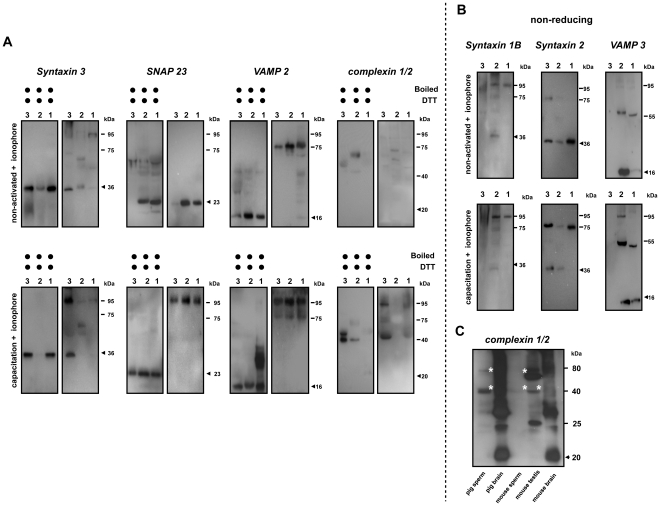
Bicarbonate and Ca2+ ionophore incubation results in MVs that contain high amounts of SNARE protein complexes.(A) When MVs were formed in the presence of bicarbonate and Ca2+ ionophore, a considerable amount of SNARE protein complex was present at 95 kDa (lower panels). A minimal amount of 95 kDa SNARE complexes was observed in MVs from the non-activated sperm when AE was induced by Ca2+ ionophore in the absence of bicarbonate (upper panels), although a 75 kDa VAMP 2 was found under this bicarbonate depleted condition. Besides the three interacting SNARE proteins found in the MVs, we also identified the capacitation-dependent participation of soluble complexin with the SNARE containing complex. (B) This shows the absence of previously reported SNARE proteins (to some extent syntaxin 1B is present in a 95 kDa complex but syntaxin 2 and VAMP 3 are not participating) in the non-activated MVs indicating that pre-docking and fusion of the acrosome with the PM requires different sets of SNARE proteins. (C) Identification of sperm and testis specific forms of complexin. To demonstrate that the unexpected 40 kDa complexin was not an artifact, whole sperm lysates and a mouse testis tissue homogenate were used. For the comparisons between different tissues, both pig and mouse brain homogenate were included. Despite the presence of multiple complexin positive bands, we found in both mouse and pig brain, a huge amount of complexin monomer was present. In contrast to the specific detection of 40 and 79 kDa complexin (marked with asterisks) in the sperm and testis, no 40 kDa complexin can be detected in the brain tissue of both species suggesting this unexpected 40 kDa complexin is a sperm-specific form rather than the artifact. A total of 35 µg crude protein was loaded to each lane of these Western blots from: 1: whole sperm cell lysate; 2: the remaining sperm head fraction (in the absence of MVs); 3: MVs. Samples were either incubated at the RT in the absence of reducing agent (non-reducing conditions) or boiled at 100°C for 10 min in the presence of 0.1 M DTT (reducing conditions). The arrows indicate the expected molecular weight of protein on the Western blot.